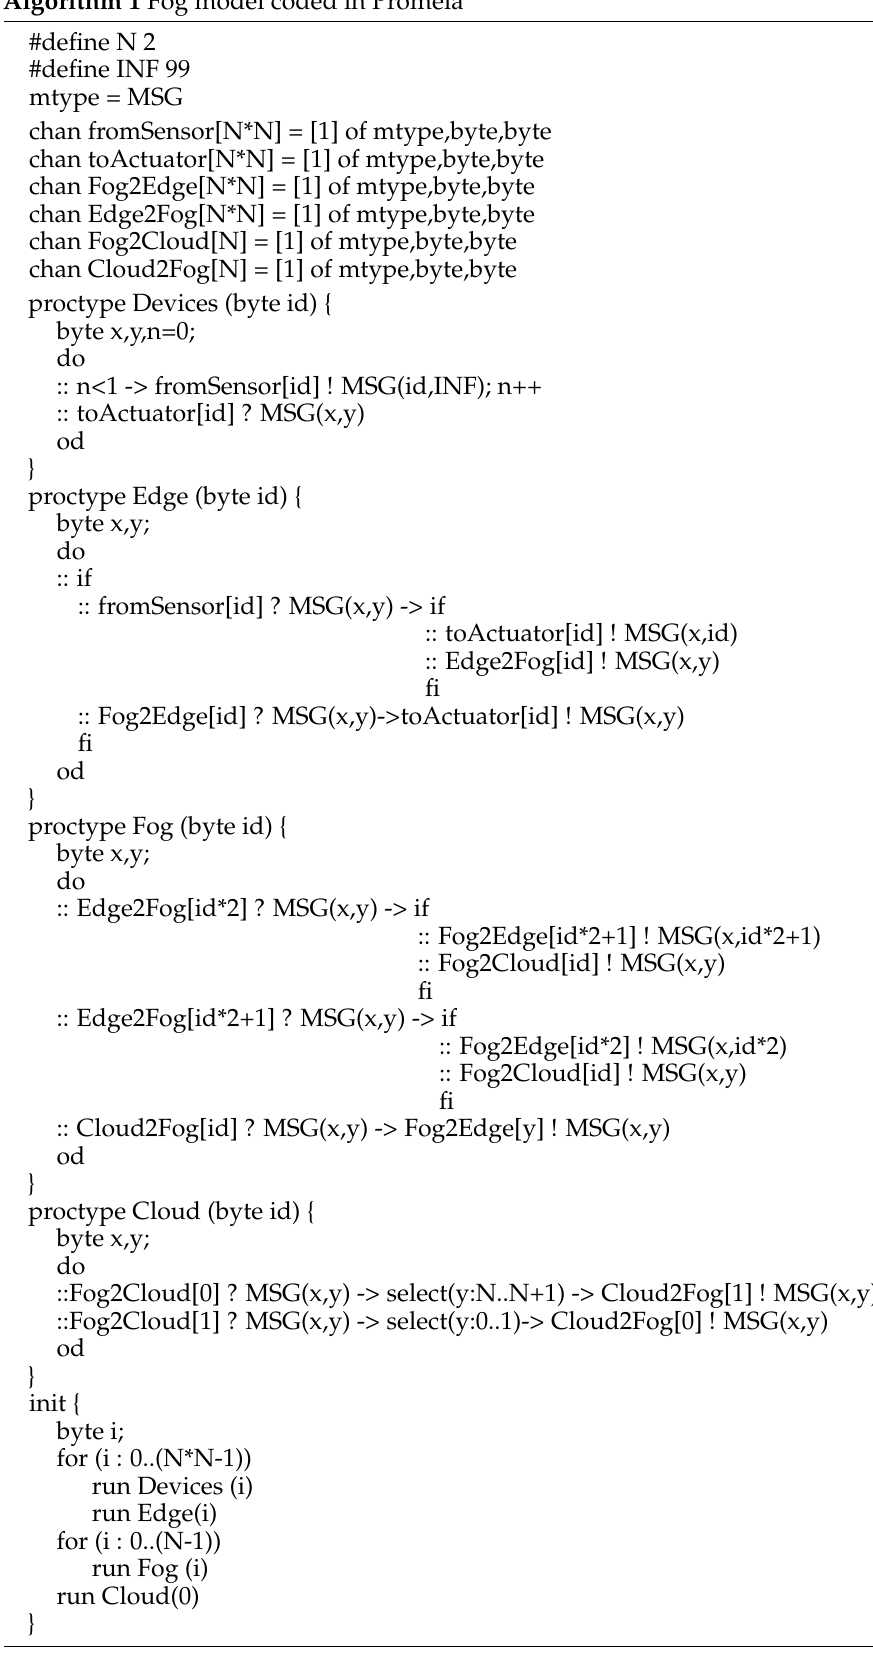
Algorithm 1 Fog model coded in